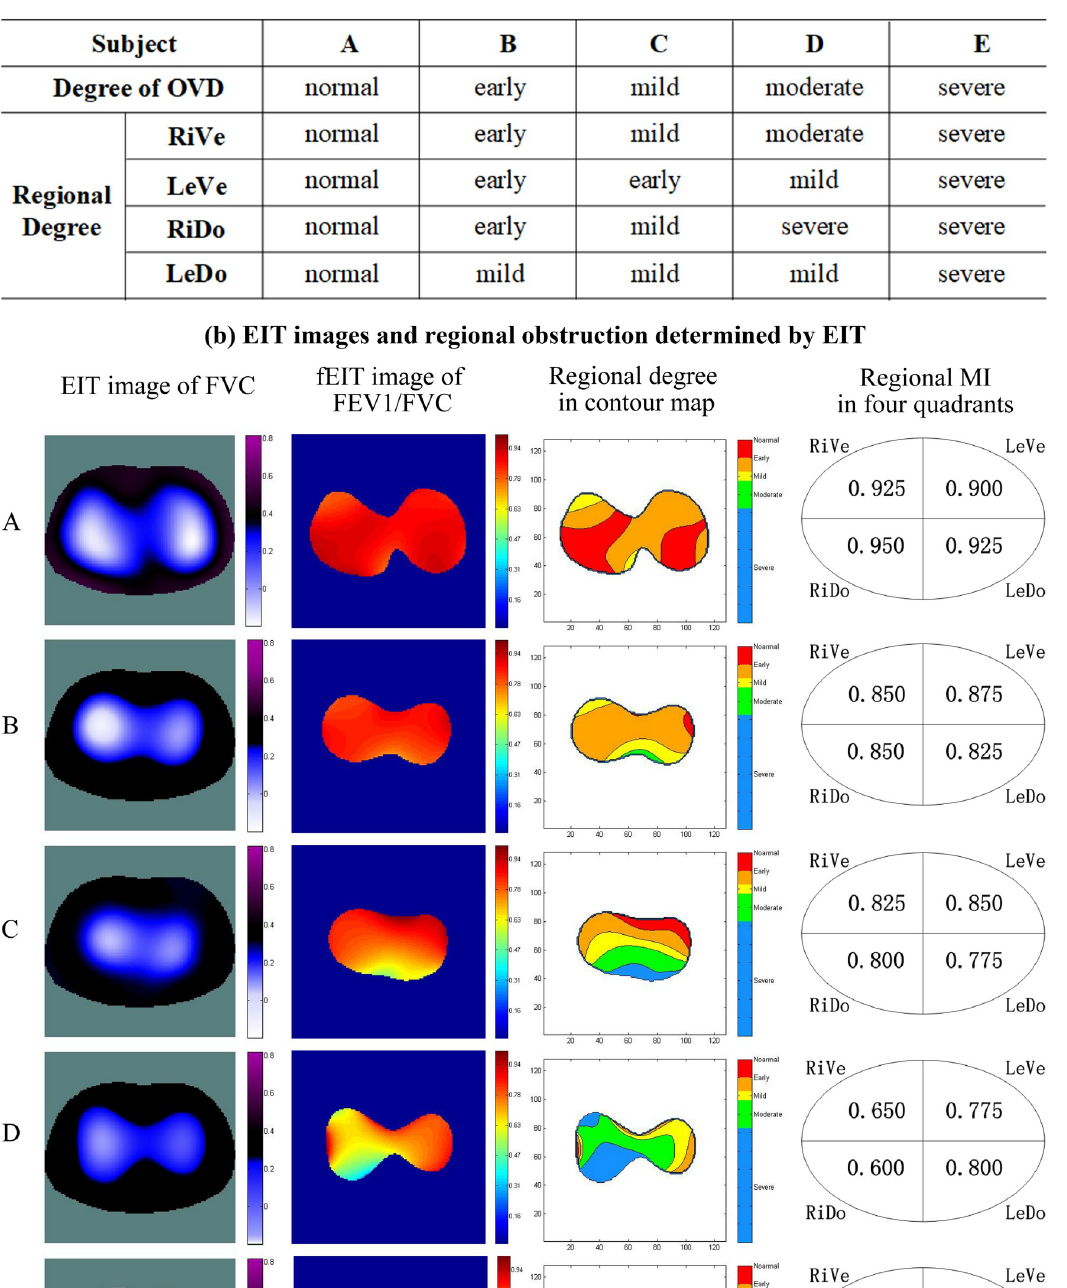
PLOS ONE | https://doi.org/10.1371/journal.pone.0209473 December20,